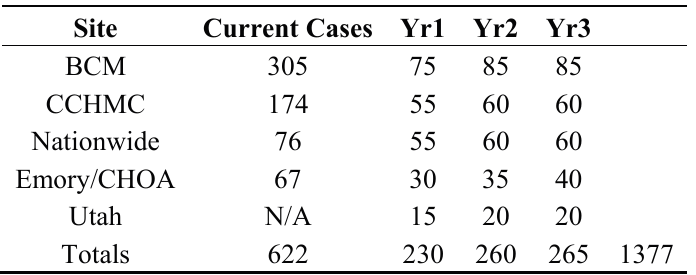
Table 3. Current and Projected